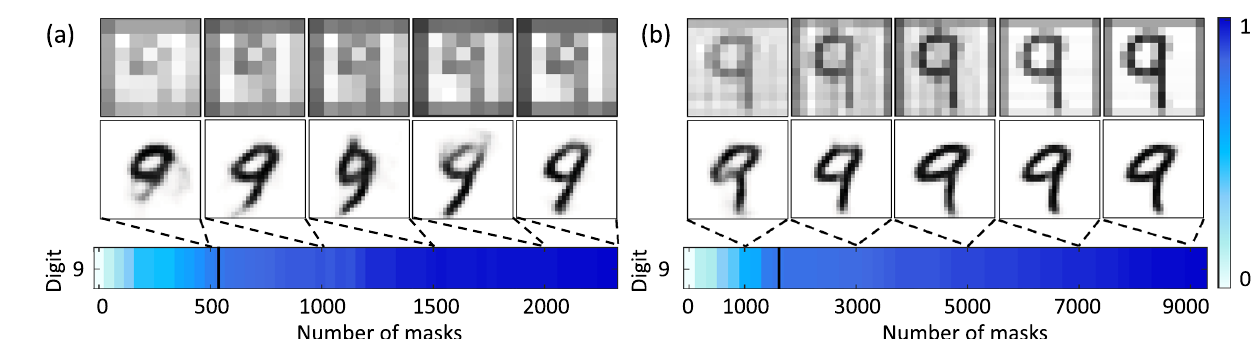
Figure 5. Comparison of the two-step approach for Walsh 2D and Random masks. ( a ) The reconstructed images at 20, 40, 60, 80 and 100% image reconstruction time respectively, for 48 × 48 pixel Walsh 2D masks. Followed by the corresponding enhanced images from the auto-encoder output. The confidence level, predicted by the recognition algorithm after enhancement, only for digit 9 is shown beneath. ( b ) Here we show the same aspects as ( a ) however 10,000 random masks were used in comparison to the Walsh 2D masks. The solid black lines show the imposed stopping point for each case. It can be seen that the Walsh 2D masks converge × 10 faster than the random masks.